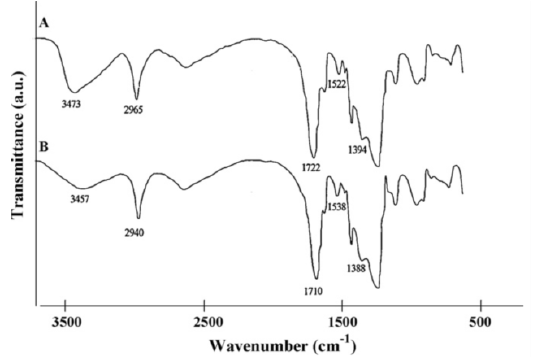
Figure 3. Infrared spectra of the leached (A) and unleached (B) MIP particles.